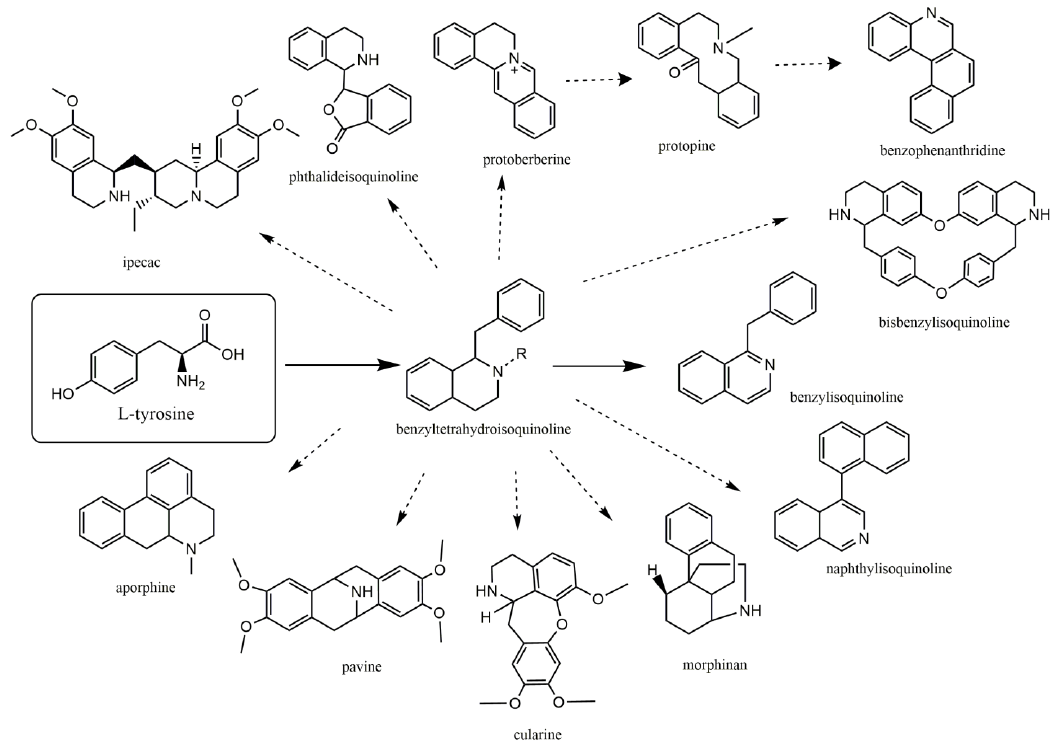
Figure 1. Some important L-tyrosine-derived isoquinoline and their related alkaloids.